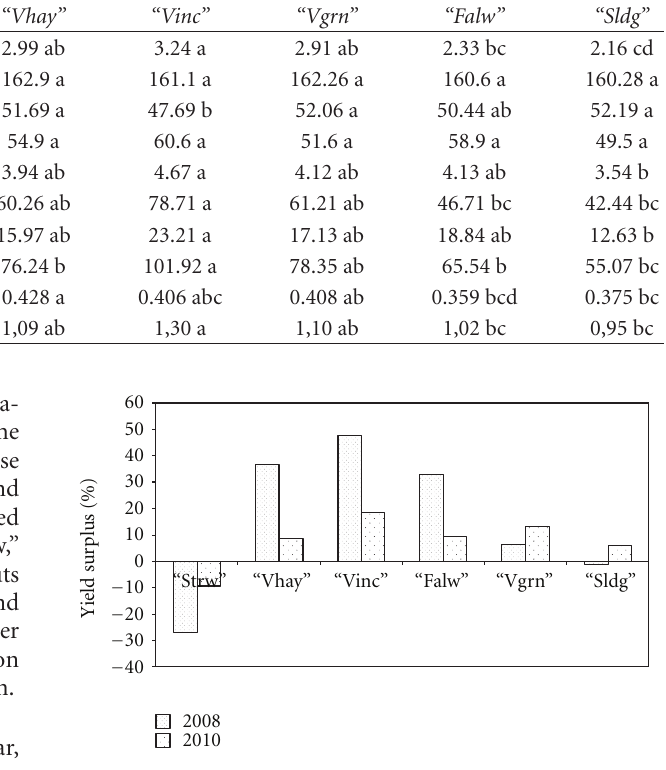
Figure 2: Percentage di ff erence of grain yield of each treatment in relation to the conventional treatment at the very dry year of 2007/08 and the normal rainfall year of